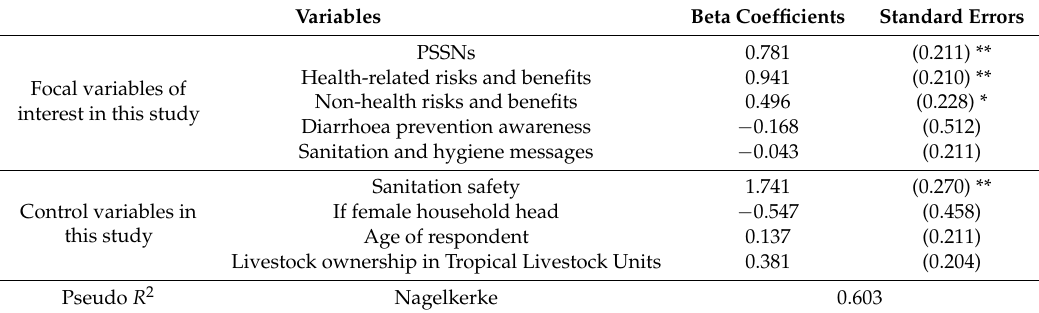
Table A3. Predictors of satisfaction with current sanitation practice (full-specification of main effect model; i.e., including regression estimates for control variables), binary logistic